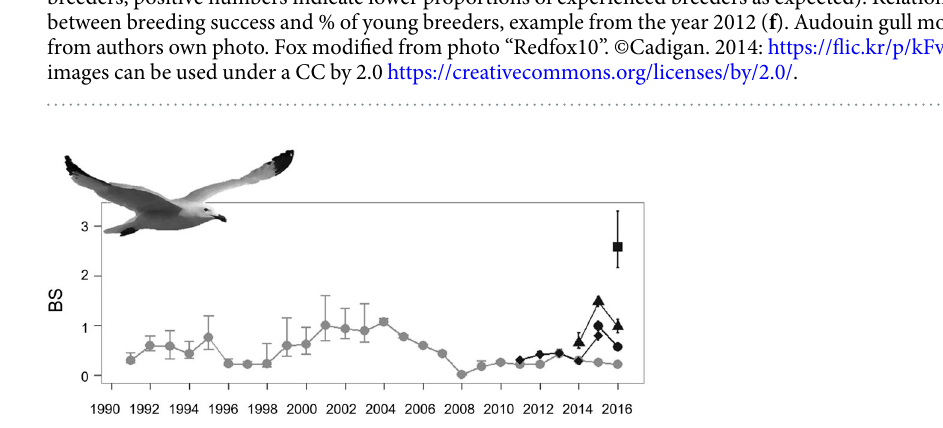
Figure 3. Breeding success (chicks/pair) and 95% IC of different Audouin’s gull breeding colonies: Punta de la Banya (light grey circles), La Ràpita (diamonds), Sant Antoni (solid dots), Tarragona Port (square) and Castellón (triangles). Audouin gull modified from authors own photo. The image can be used under a CC by 2.0